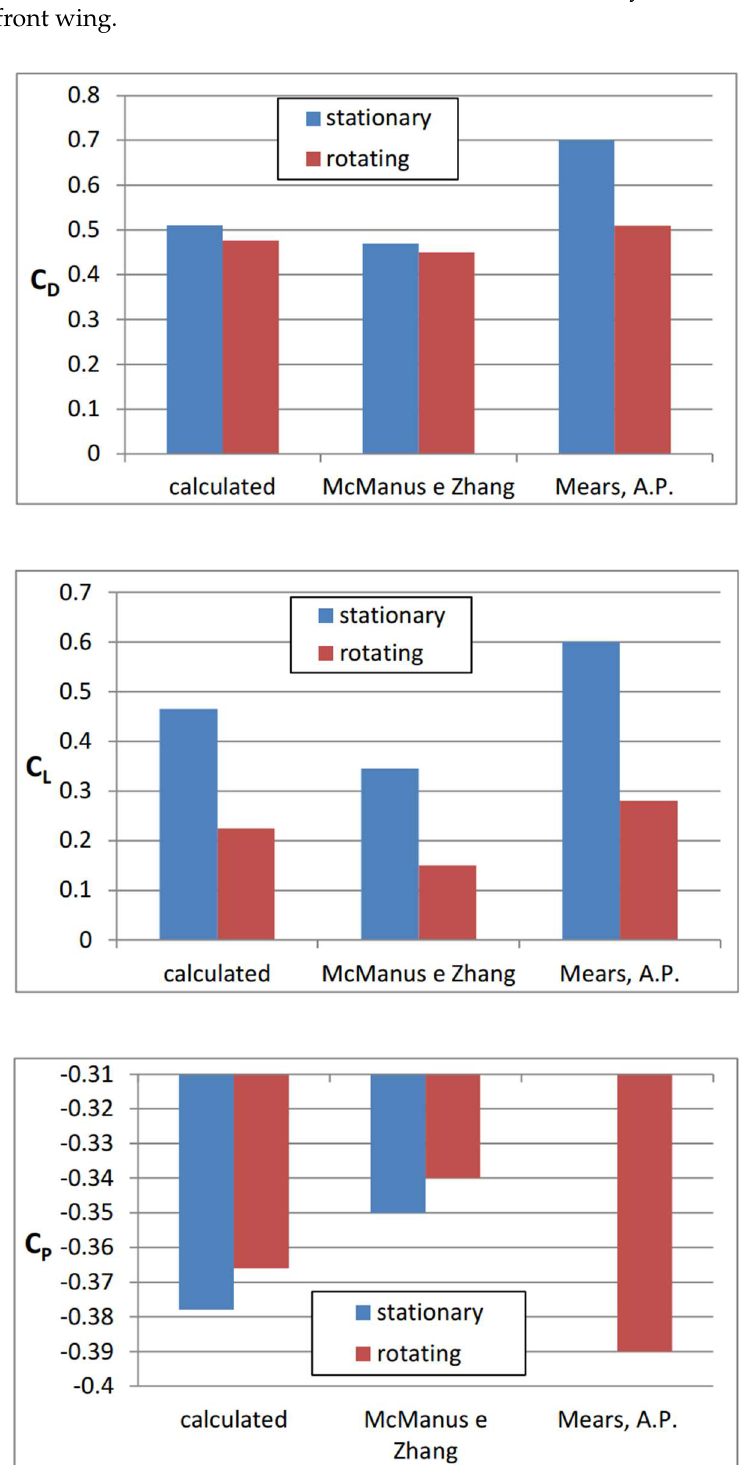
Figure 6. Aerodynamic coefficients of isolated wheels.